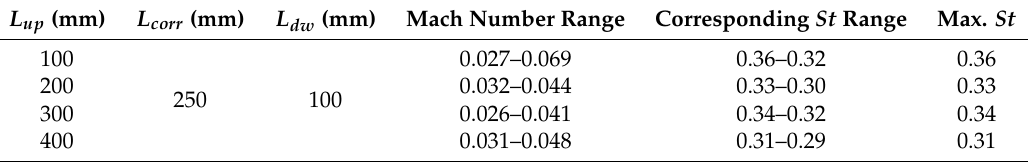
Table 11. Mach number range, corresponding Strouhal number ( St ) range and maximum Strouhal number for each pipe configuration in Case